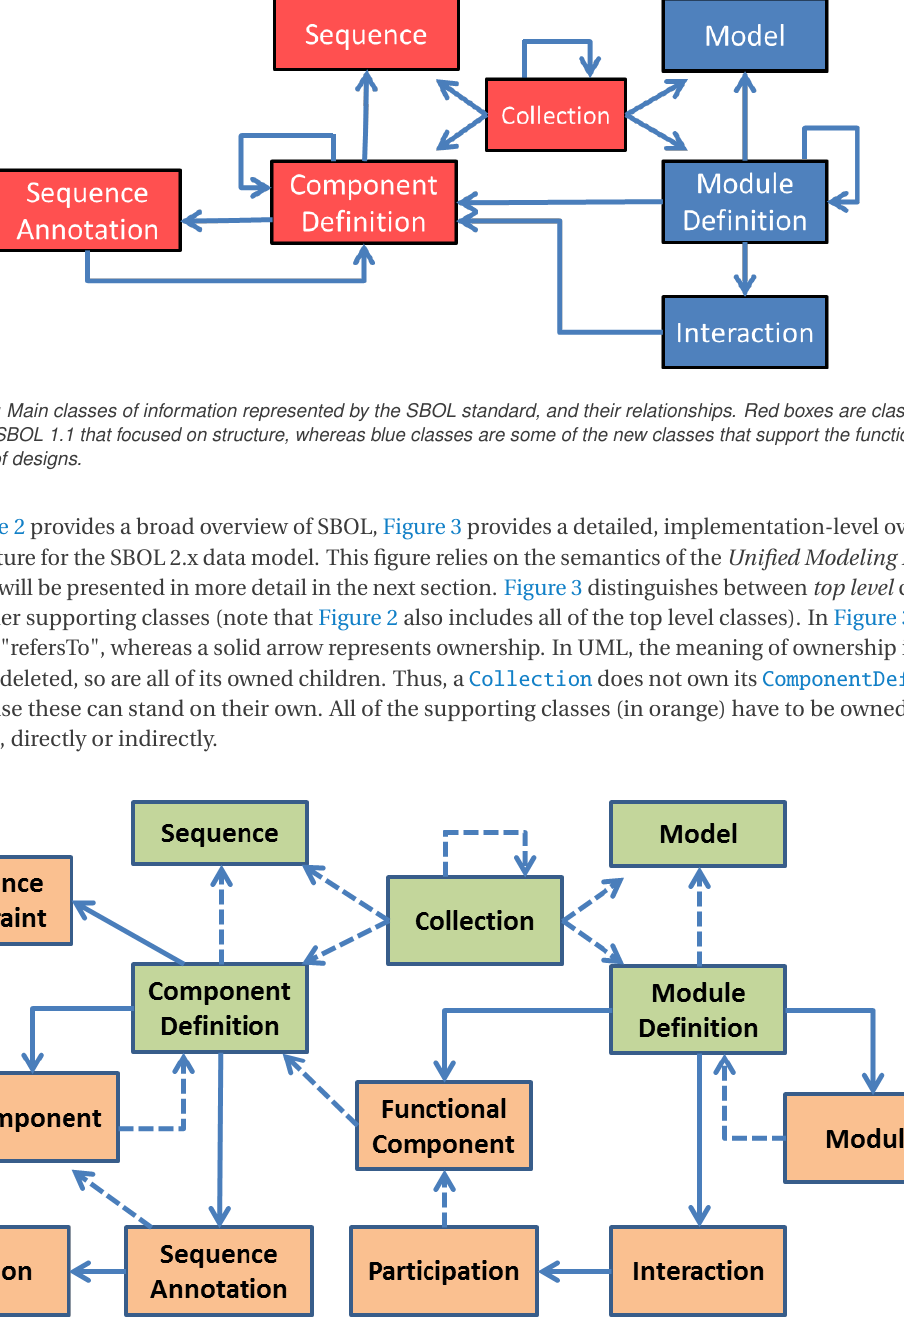
Figure 3: Main classes of information represented by the SBOL 2.x standard, and their relationships. Green boxes are “top level” classes, while the other classes are in support of these classes. Solid arrows indicates ownership, whereas a dashed arrow indicates that one class refers to an object of another